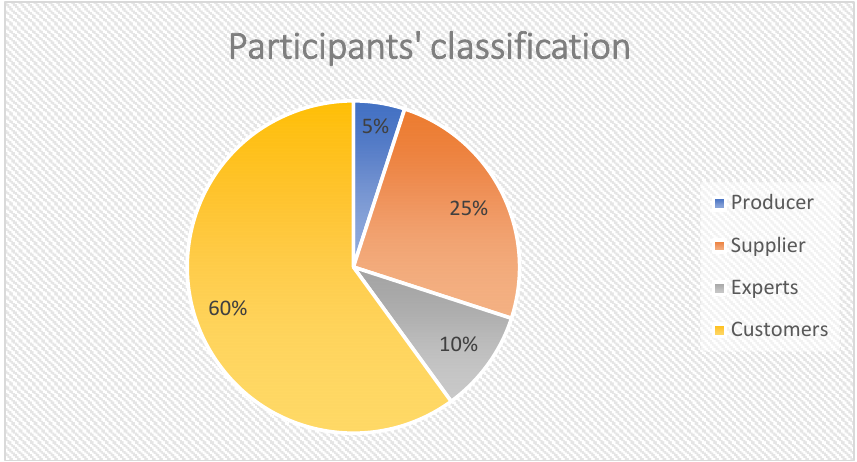
Figure 6. Distribution of participants by category.